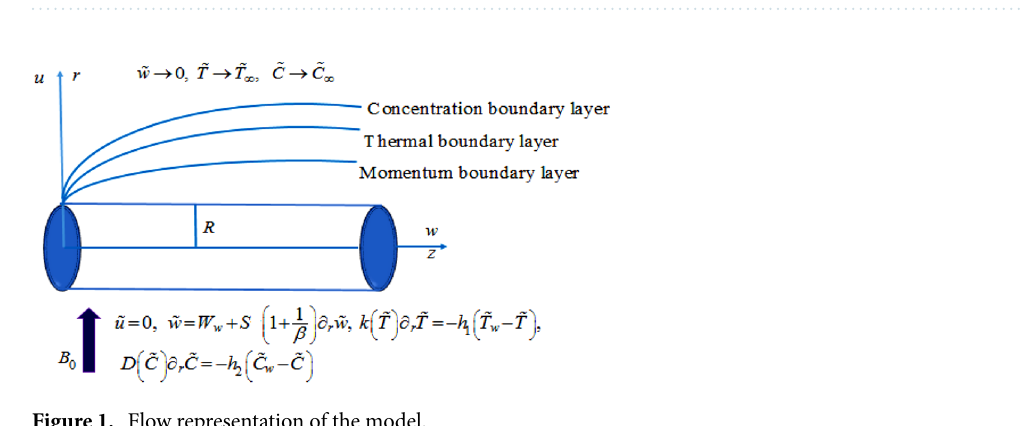
Table 1. An inspection of literature for the innovation of the presented model.